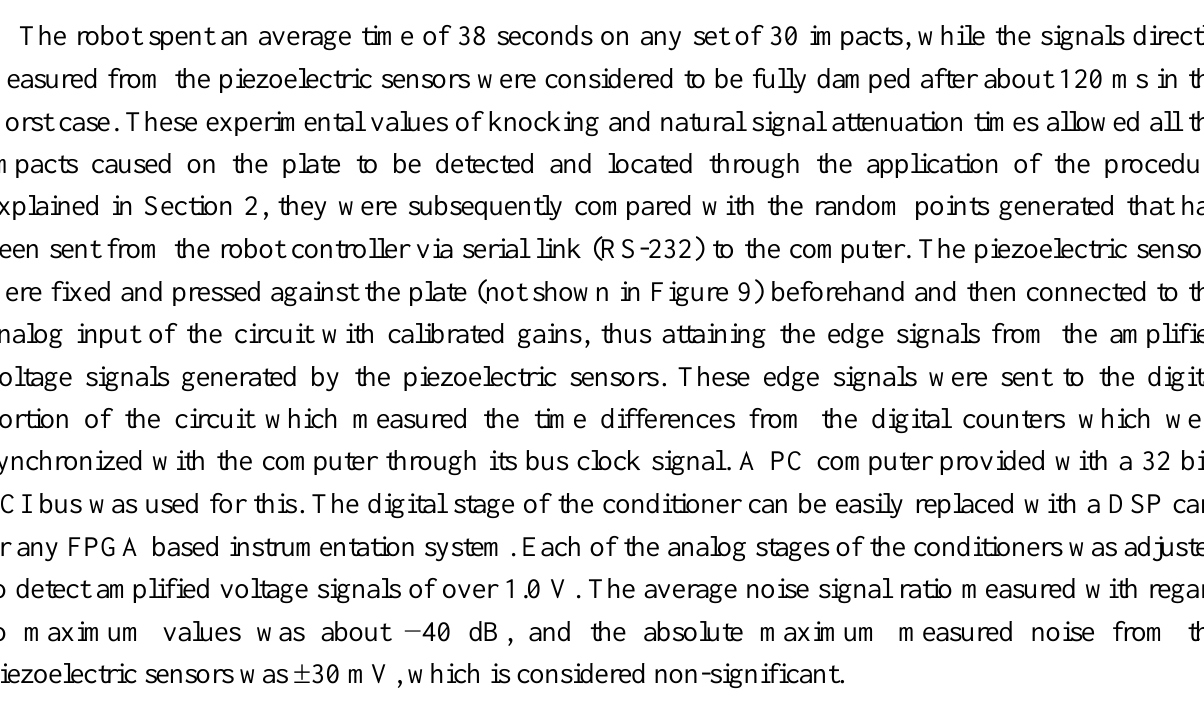
Figure 11. (a) Voltage signals from piezoelectric sensors after an impact; ( b ) Time differences at peak amplitudes of signals S of signals S and S ; ( d ) Time differences at peak amplitudes of signals S 1 3